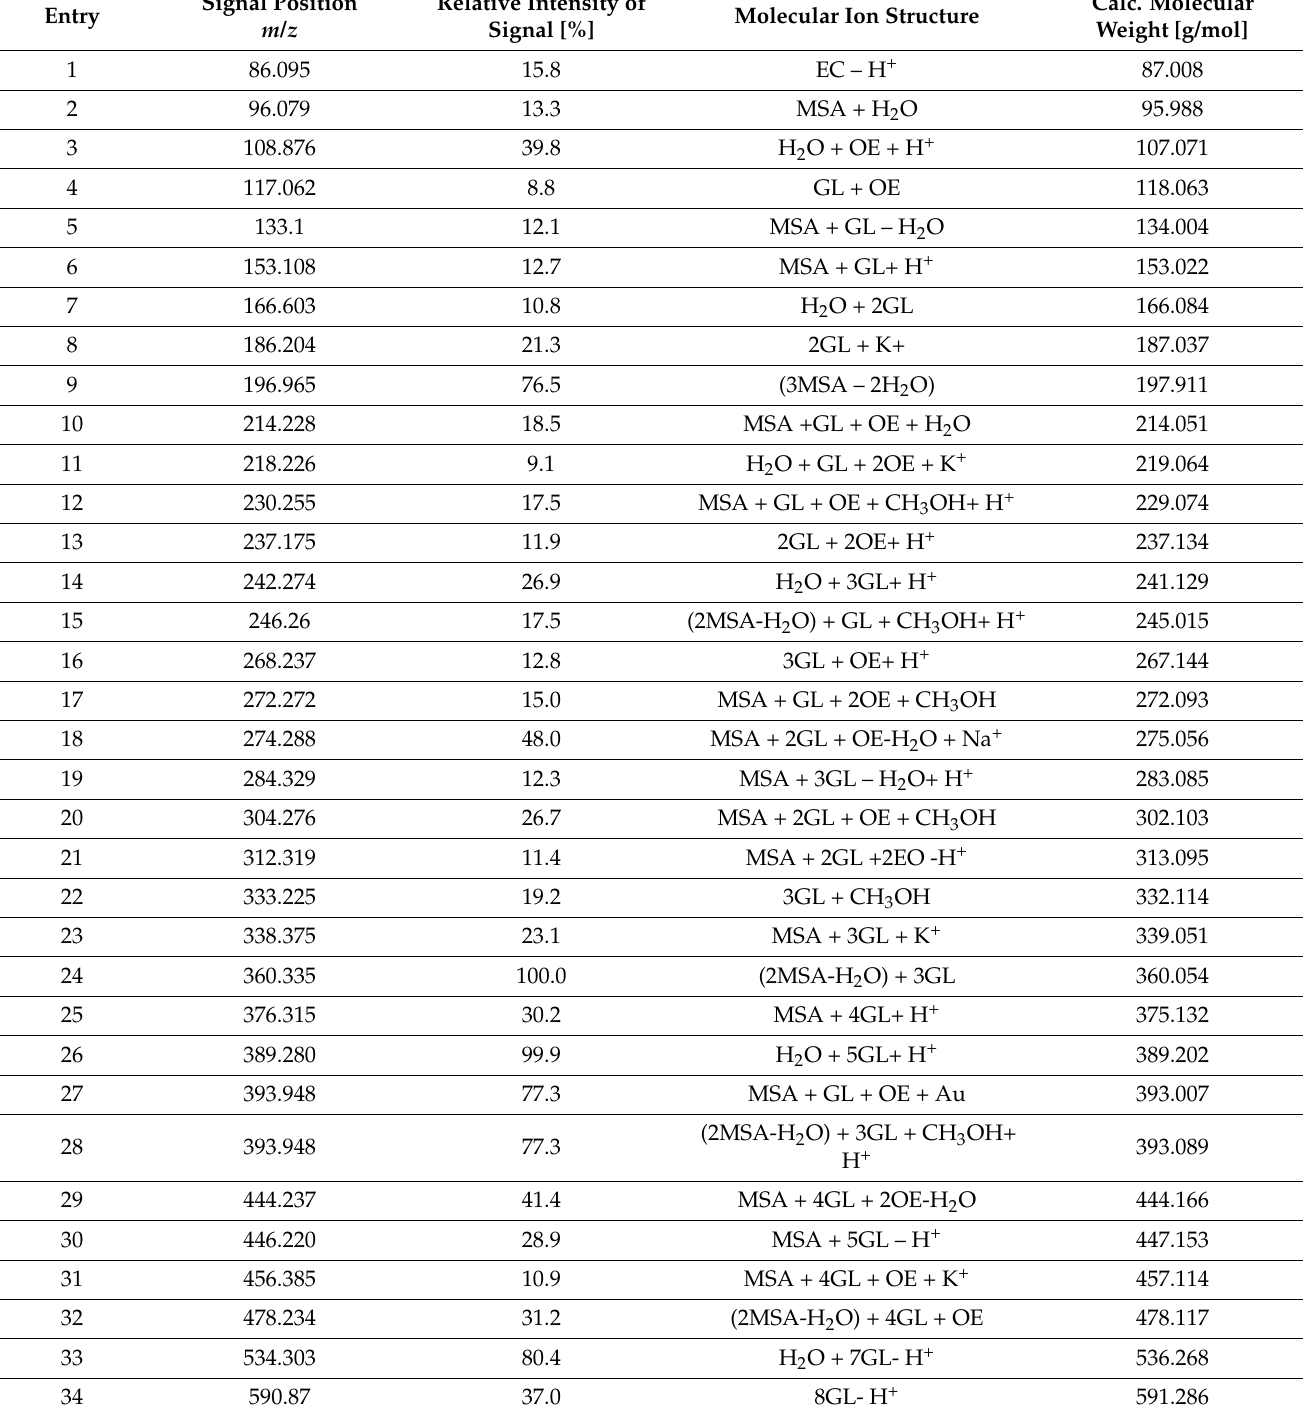
Table 4. Interpretation of MALDI-ToF spectrum of